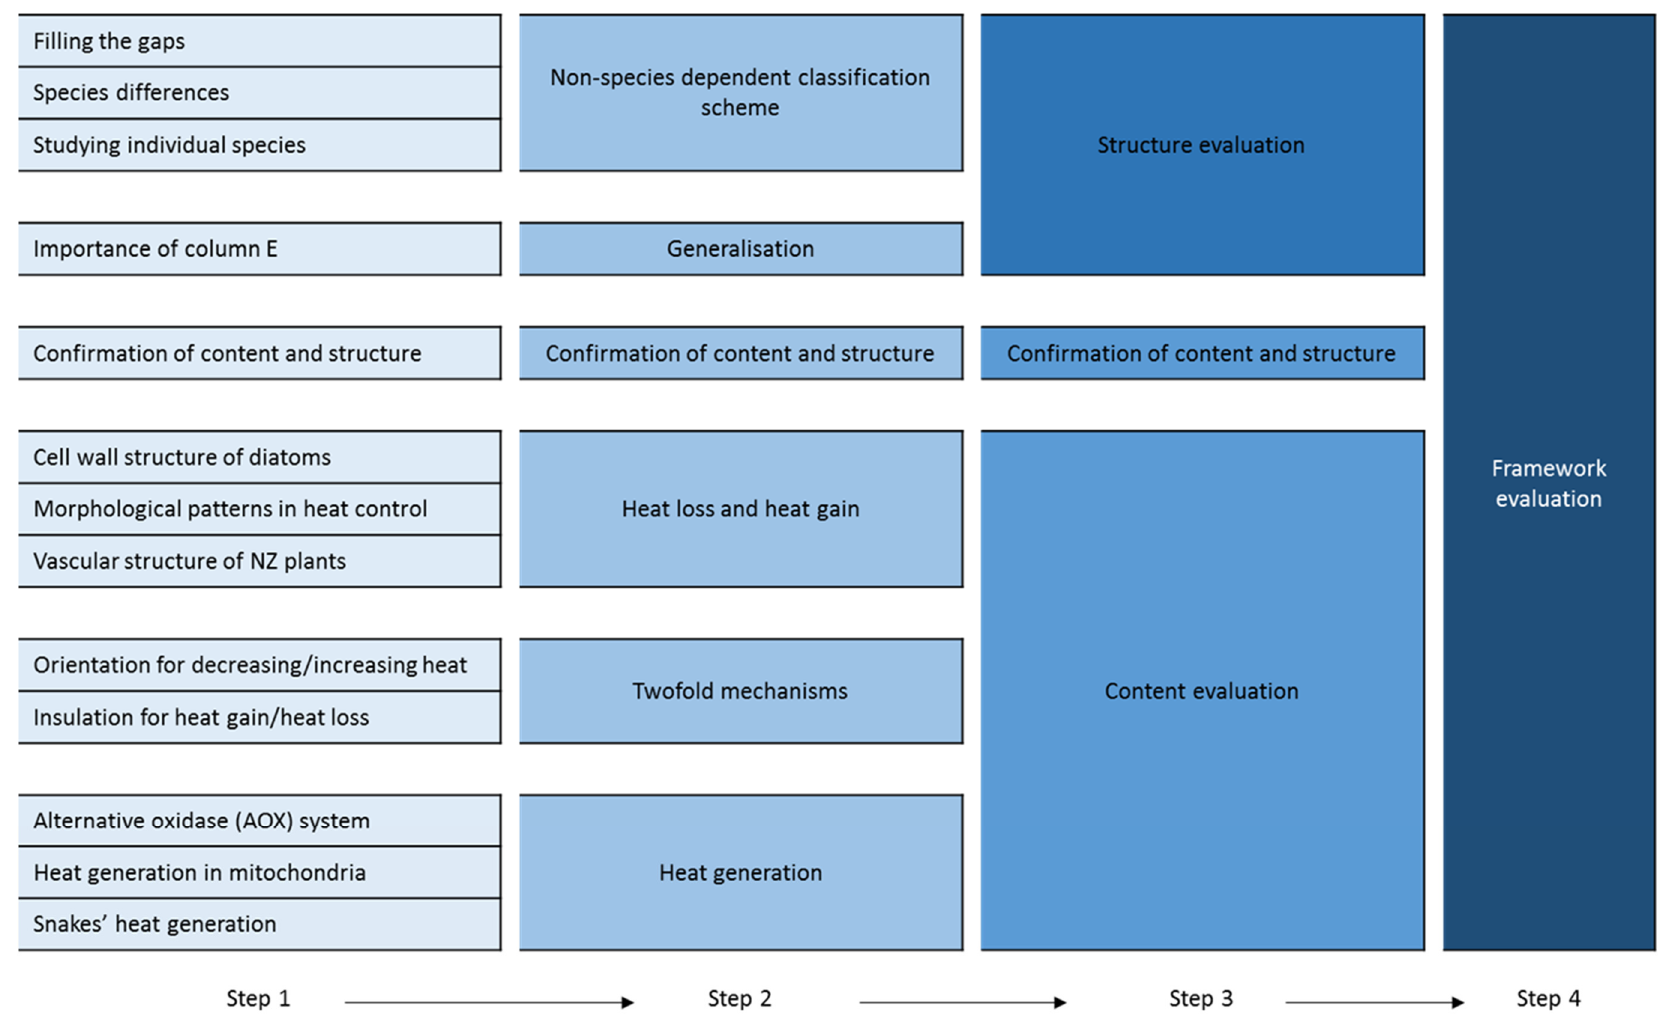
ff erent stages of coding based on the second theme ‘framework Figure 2. Different stages of coding based on the second theme ‘framework evaluation’. Figure 2. Di